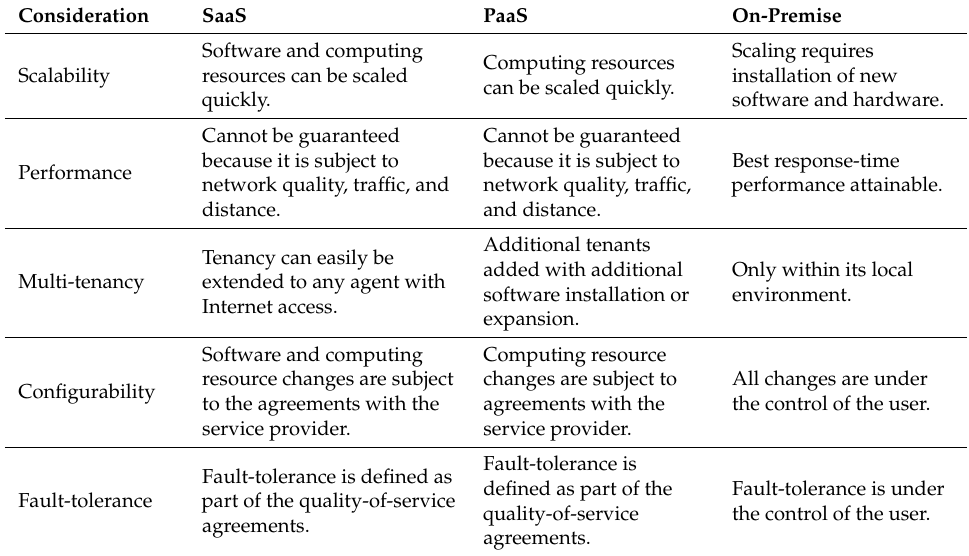
Table 1. Advantages and disadvantages of SaaS, PaaS, and on-premise models in relation to the five considerations for